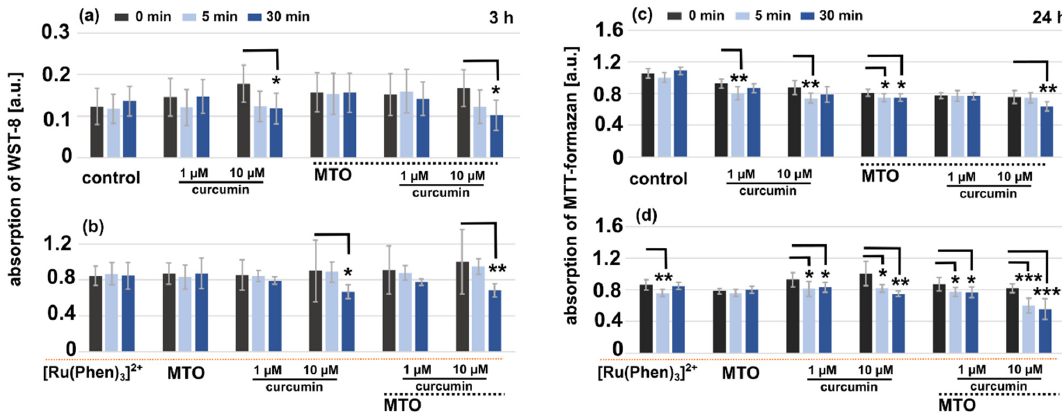
Figure 12. Metabolic activity test of U87 MG cells performed with ( a,b ) WST-8 and ( c,d ) MTT-formazan 3 and 24 h after the irradiation, respectively. The cells were pre-treated during 1 h with 1 and 10 µM curcumin, 400 nM MTO, and 200 µM [Ru(Phen) 3 ] 2+ , individually or in combinations, as represented by histograms. The histograms present the results obtained in the ( a , c ) absence, and ( b , d ) presence of [Ru(Phen) 3 ] 2+ . The cells were irradiated with blue light (463 ± 10 nm; 100 µW/cm 2 ) for 5 and 30 min. The average values presented correspond to the means of two independent measurements. Error bars: standard deviations from the mean values. The level of significance was estimated by the Student t -test: * p < 0.05, ** p < 0.01, and *** p < 0.001.